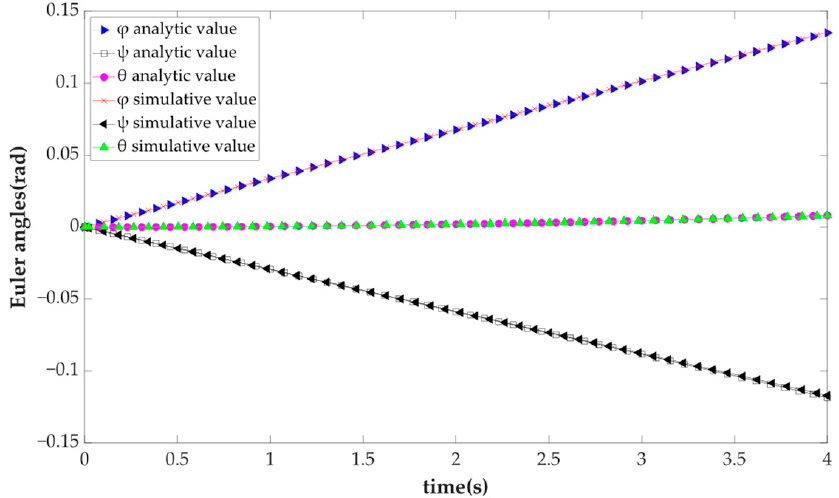
Figure 8. The comparison between analytic results and simulative results of posture parameters of m . The curves of the positional parameters from the analysis and simulation are shown in Figure 9.